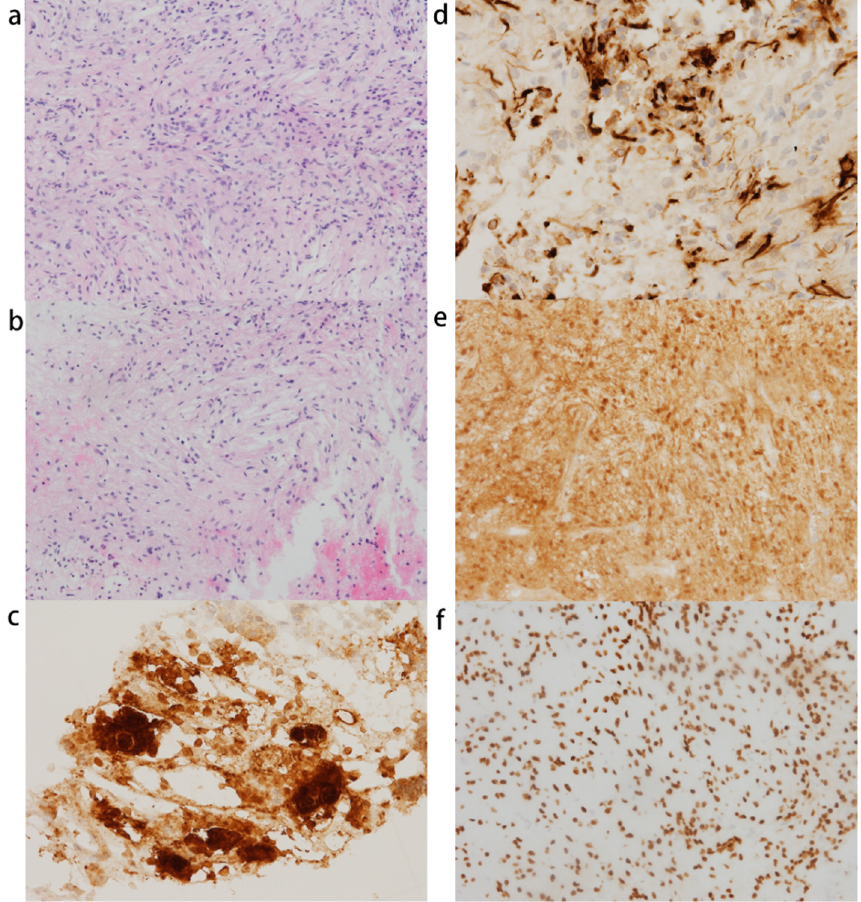
Figure 4. Pituicytoma in case 2: ( a , b ) hematoxylin-and-eosin (H&E) staining shows spindle cells in a mostly fascicular arrangement (×200); ( c ) ACTH staining in adjacent pituitary gland cells; ( d – f ) GFAP, S-100, and TTF-1 were positive in pituicytoma.